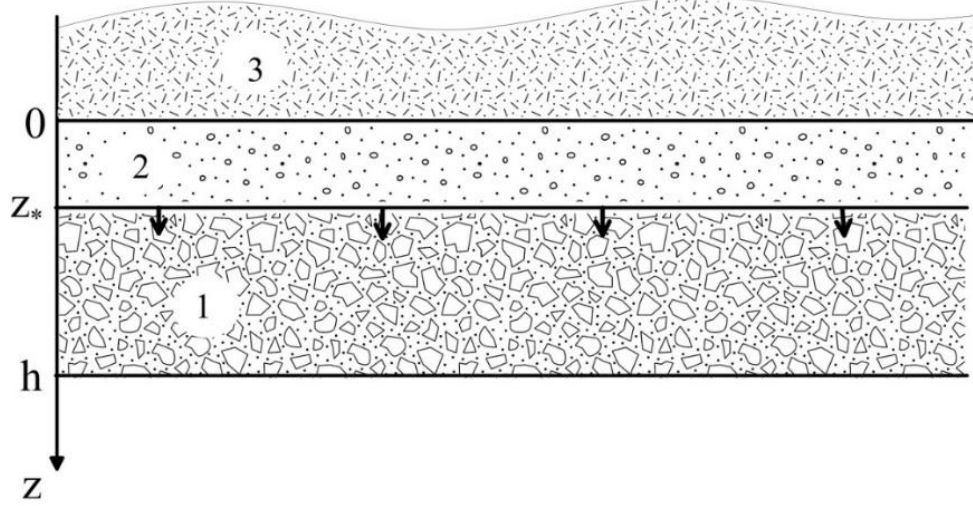
Figure 3. Sketch showing the model geometry: 1 — hydrate and ice-bearing reservoir; 2 — part of the reservoir behind the hydrate decomposition front, containing saturated ice and gas; 3 — fractured porous medium discharging the gas into the water column or atmosphere; z ∗ is the position of hydrate decomposition front.